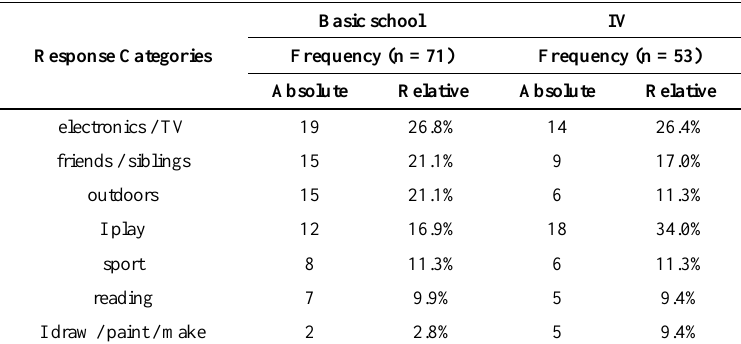
Table 5. When you can make your own decisions, what do you like to